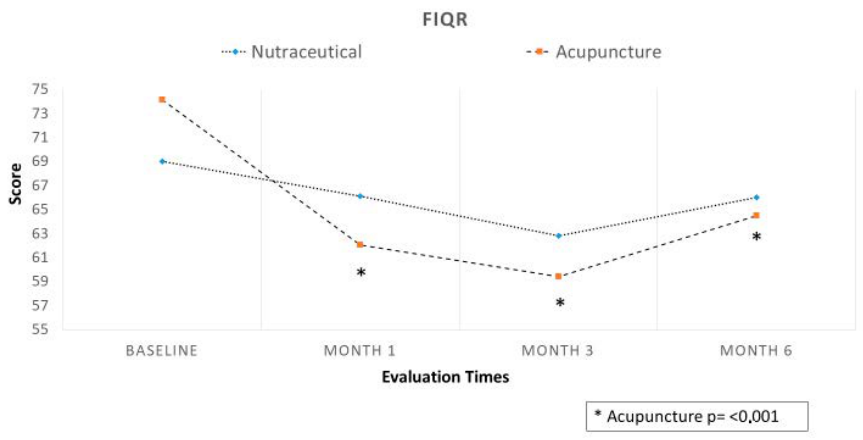
Figure 4. Secondary efficacy end-point in analyzed population: change in Fibromyalgia Impact Questionnaire Score-Revised (FIQ-R) score during observation. The evaluation shows a statistically significantly score reduction only in Acupuncture Group at all the observations ( p < 0.001).